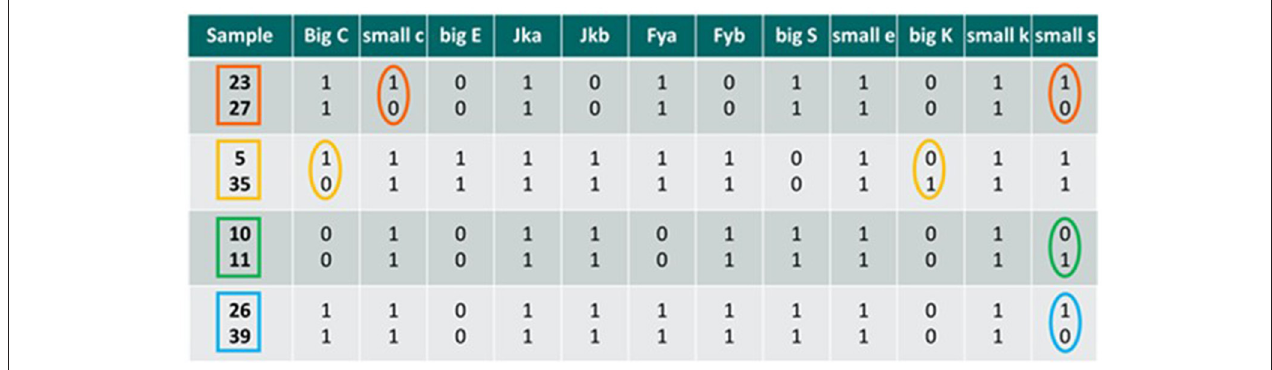
FIGURE 3 | Comparisons between mixed samples; the antigenic differences detectable by the method are highlighted in circles in the case a transfusion occurs between the two individuals considered. 0, antigen non-expressed; 1, antigen expressed. Big C, small c, big E, Jka, Jkb Fya, Fyb, and big S are the base panel antigens, while small e, big K, small k, and small s are the new antigens